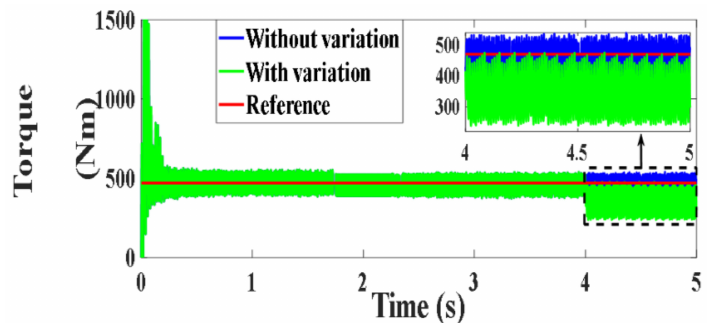
Figure 165. Developed torque under PVC (Nm).